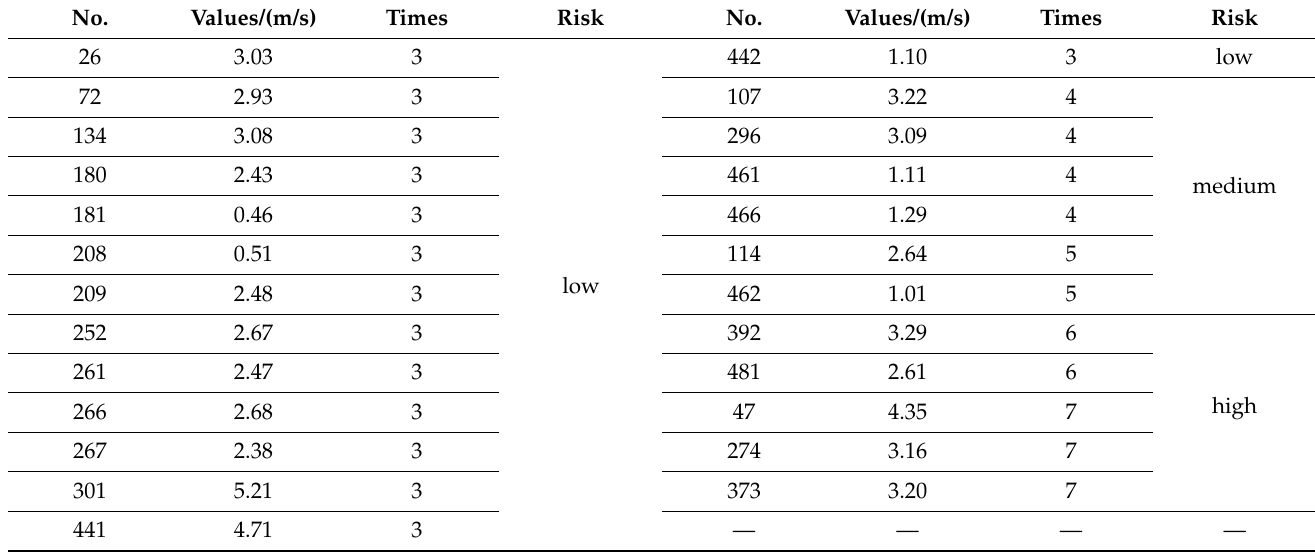
Table 2. Risk table of monitoring data.